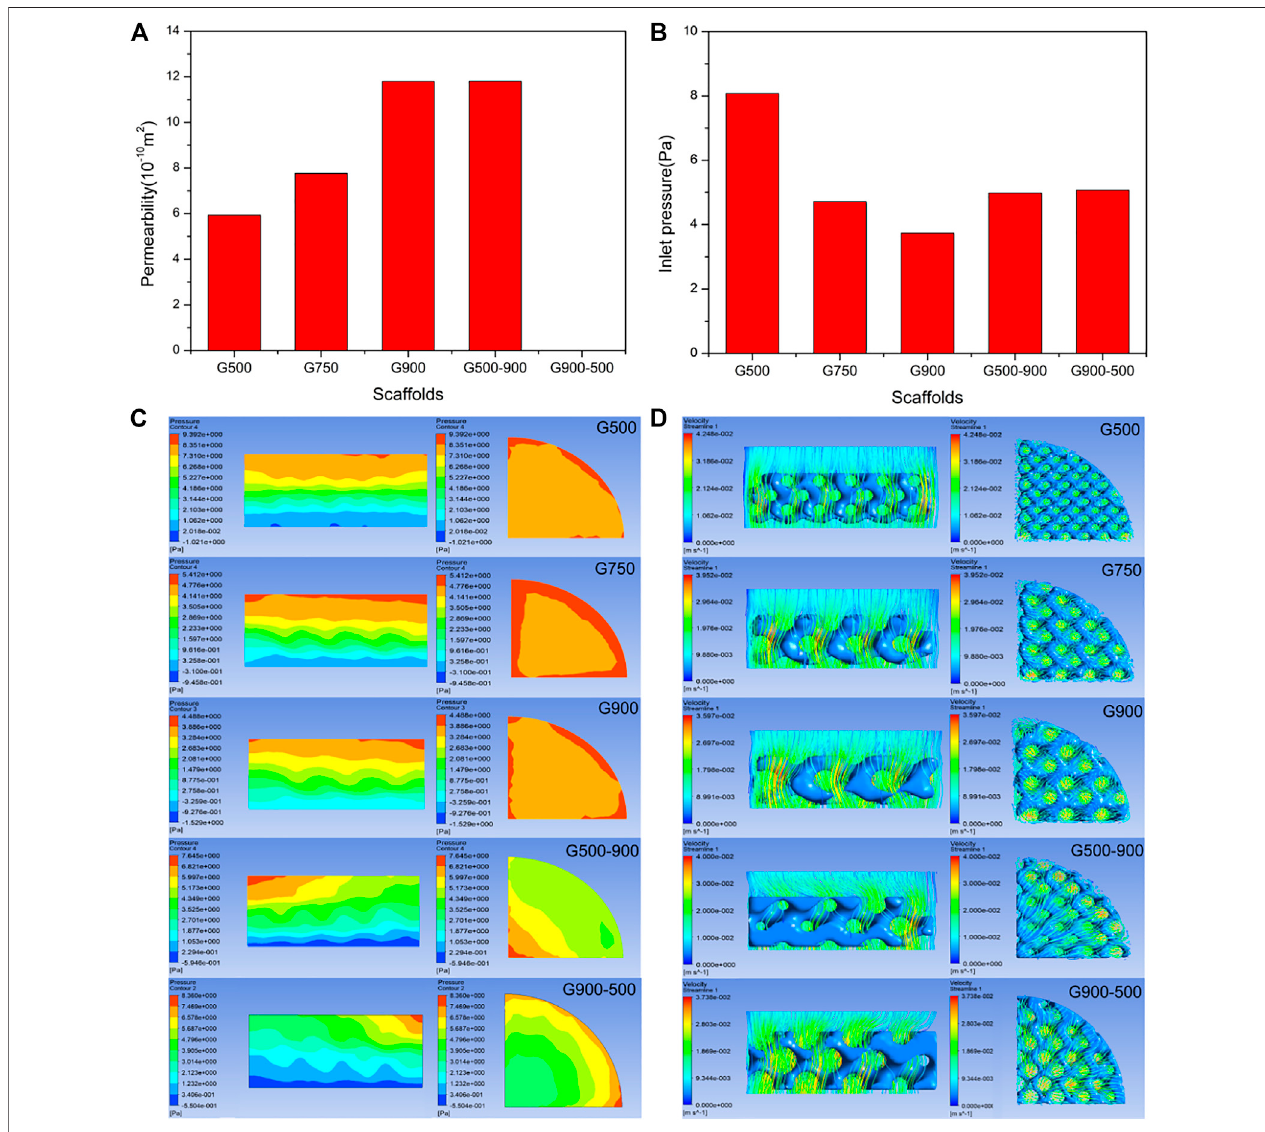
FIGURE8| Resultsofthepermeabilitytestand fi niteelementsimulationofporousscaffolds: (A) permeabilitytestresults(thepermeabilityoftheG900-500scaffold is not recorded due to the formation of preparation defects). (B) Inlet pressure results are calculated by fi nite element simulation. (C) Fluid pressure distribution cloud diagram. (D) Fluid fl ow velocity distribution diagram. (It should be noted that media of the experiment and simulation are water and human body fl uid, respectively).